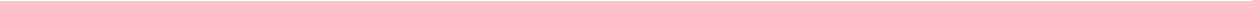
Fig. 7 Engineered heterotrimeric SyCyRs of IL-23R are capable of STAT3 trans-phosphorylation in transduced Ba/F3-gp130 cells. a Schematic illustration of IL-23R-SyCyRs simulating STAT3 trans-phosphorylation. The 2xGFP-mCherry fusion protein served as synthetic cytokine ligand. G VHH -IL-23R- Δ STAT consists of the GFP-nanobody fused to 16 aa of the extracellular part, the transmembrane and intracellular domains of the IL-23R lacking STAT-binding motifs. The C VHH -IL-23R- Δ JAK variants consist of the mCherry-nanobody fused to 16 aa of the extracellular part, the transmembrane and intracellular domains of the IL-23R lacking the JAK activation site ( Δ JAK-A,-B,-C). b Analysis of JAK activation in Ba/F3-IL-23R- Δ STAT cells. Cells were washed three times, starved, and stimulated with 100 ng/ml of the indicated synthetic ligands for 20 min. Cellular lysates were prepared, and equal amounts of total protein (50 μ g/lane) were loaded on SDS gels, followed by immunoblotting using speci fi c antibodies for phospho-JAK2 and JAK2. Western blot data show one representative experiment out of three. c Analysis of signal transduction in Ba/F3-G VHH -IL-23R- Δ STAT cells and Ba/F3-G VHH -IL-23R- Δ STAT cells stably transduced with one of the C VHH -variants depicted in a . Ba/F3-G VHH -IL-23R- Δ STAT cells and variants thereof were washed three times, starved, stimulated with 4% CHO-K1 conditioned supernatant containing mCherry, 2xmCherry or conditioned supernatant containing 100 ng/ml of the other indicated synthetic ligands for 60 min. Stimulation with HIL-23 (10 ng/ml) for 60 min and HIL-6 (10 ng/ml) for 15 min was used as control. Cellular lysates were prepared, and equal amounts of total protein (for STAT3 analysis 25 µ g/lane for HIL-6 and 50 μ g/lane for other ligands, for ERK1/2 analysis 12.5 µ g/ lane for HIL-6 and 75 µ g/lane for other ligands) were loaded on SDS gels, followed by immunoblotting using speci fi c antibodies for phospho-STAT3/ERK1/ 2 and STAT3/ERK1/2. Western blot data show one representative experiment out of two. d , e Cellular proliferation of Ba/F3-SyCyR(IL-23R), Ba/F3-G VHH - IL-23R Δ STAT cells and variants thereof with 3xGFP or 2xGFP-mCherry fusion proteins. Equal numbers of cells were cultured for 3 days in the presence of the indicated ligands (0.1 – 1600 ng/ml). Proliferation was measured using the colorimetric CellTiter-Blue cell viability assay. One representative experiment out of four is shown. Results are mean ± s.d. of three